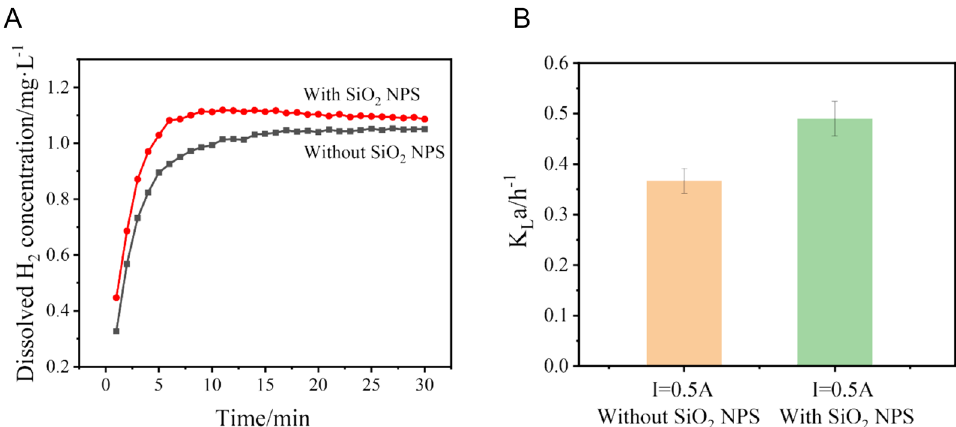
Fig. 3 The dissolved H 2 concentration curves ( A) and the K La of H 2 ( B) of reactors at 0.5 A under abiotic